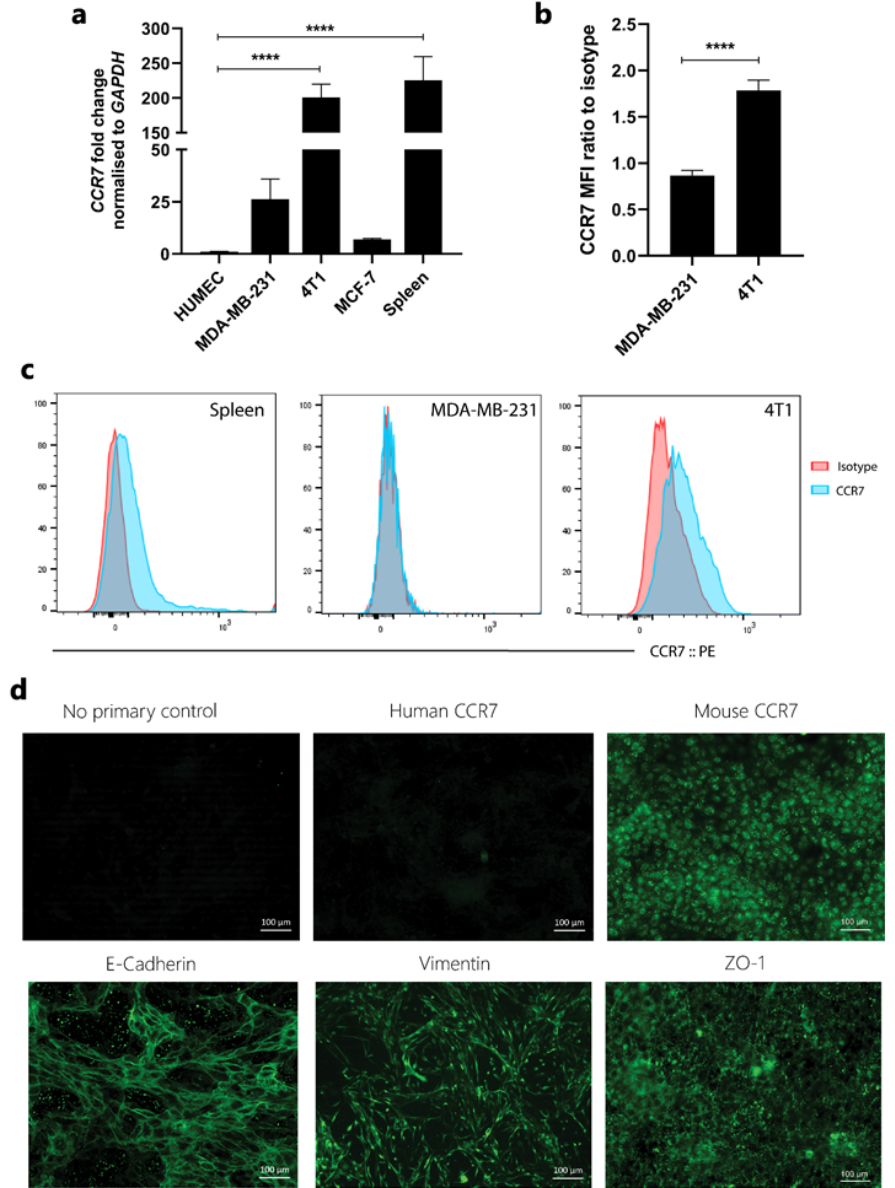
Figure 2. CCR7 expression in breast cancer cell lines. ( a ) CCR7 expression was assessed at RNA level in several breast cancer cell lines using RT-PCR and normalised to GAPDH. Fold change